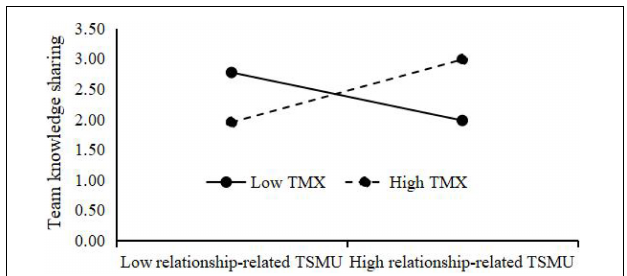
FIGURE 4 | Interactive effect of relationship-related TSMU and TMX on team knowledge sharing.